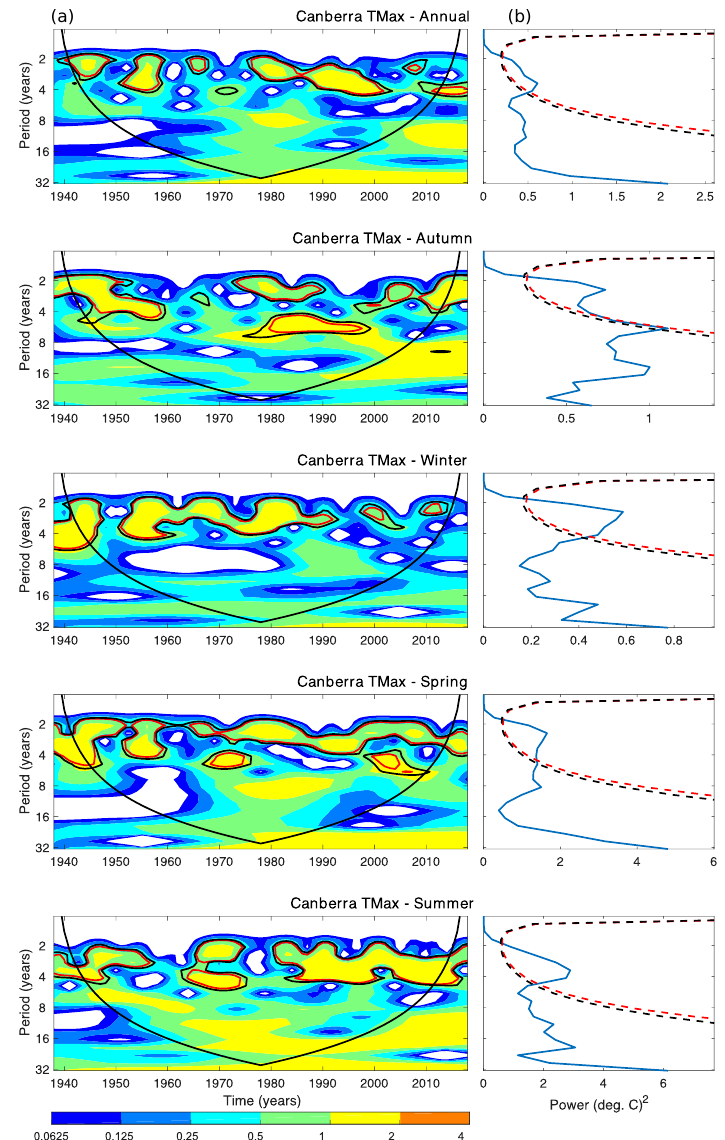
Figure 7. ( a ) Wavelet power spectra and ( b ) global power spectra for TMax, with low and high values in the power spectra indicating low and high periodicity, respectively, the cone of influence and statistical significance bands as already explained in Figure